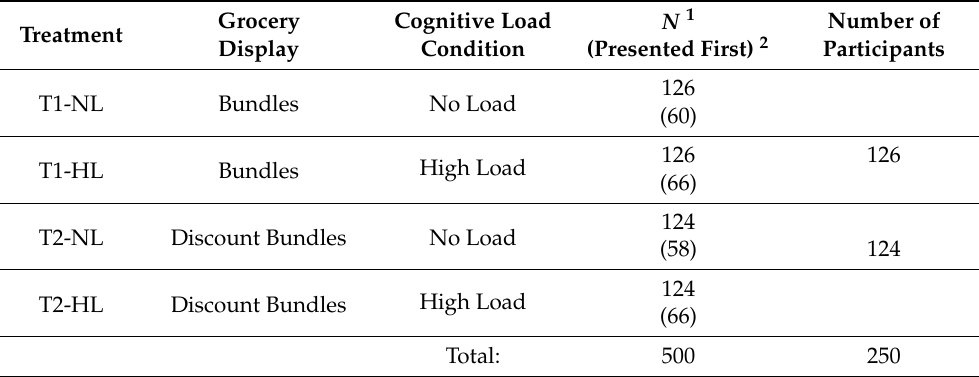
Table 2. Treatments, Grocery Shopping